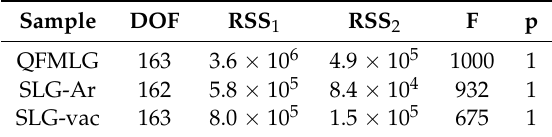
Table 1. Parameters used to perform the F-test. Degrees of freedom (DOF), Residual Sum of Squares (RSS 1 ) of the Lorentzian model and RSS 2 of the Voigt model. F is the value of the F-statistics. Number p is the p-number to reject the null